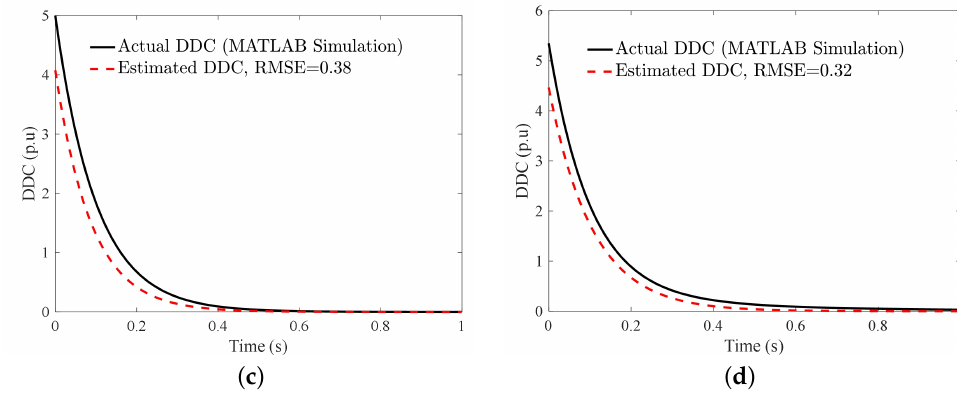
Figure 11. simulation results, method [1,6] (red line), under four different cases: ( a ) without noise, ( b ) in the presence of noise, ( c ) 0.5 Hz frequency deviation, ( d ) in the presence of the second